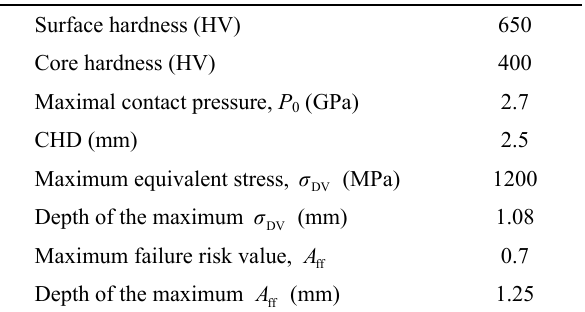
Table 2 Simulation results for case hardening material.